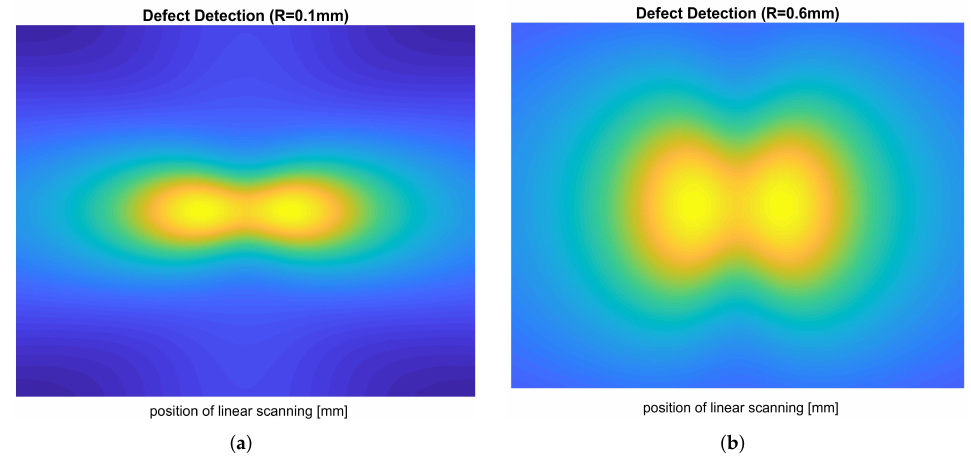
Figure 5. Reconstruction of the | B | map by COMSOL ® Multiphysics of the CFRP plate area including